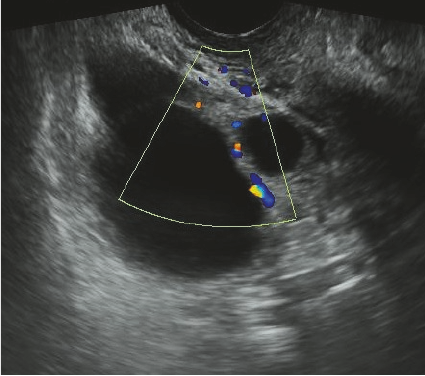
Figure 2: The cystic tumor of the right ovary had neovascularity demonstrated by color Doppler